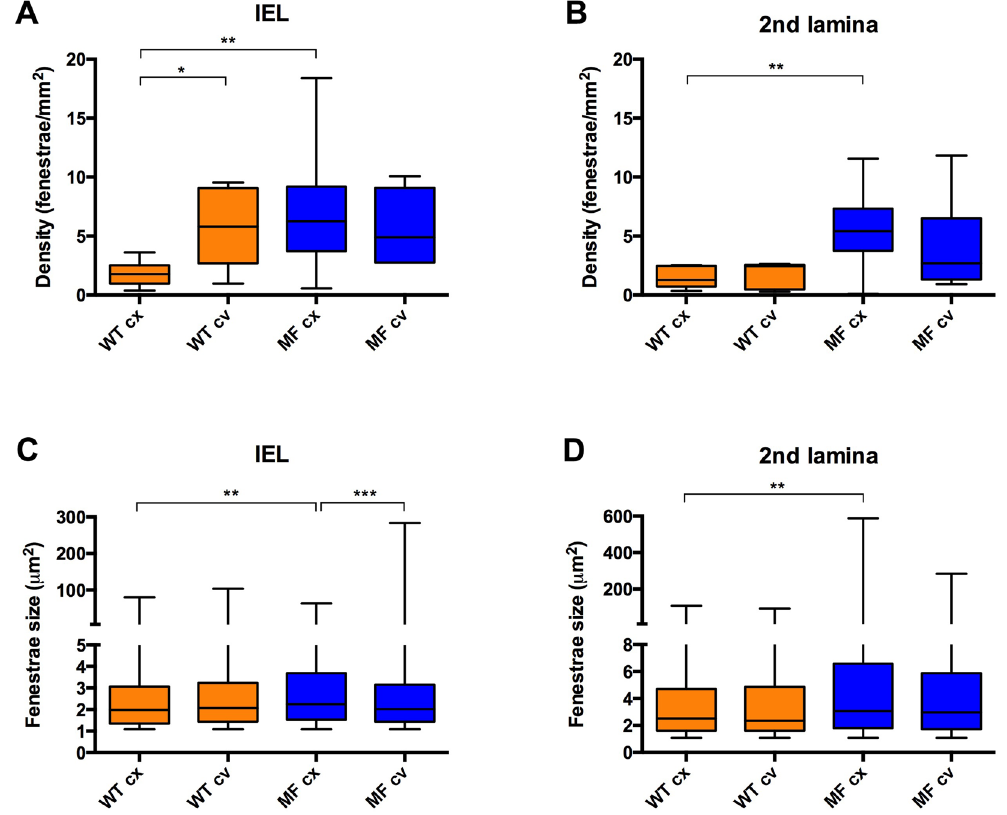
Figure 7. Quantitative analysis of fenestrae in IEL and 2 nd laminae in the circumferential plane of the ascending aorta. The density of fenestrae at the IEL ( A ) and 2 nd lamina ( B ), and their respective individual fenestrae size ( C and D ) measured at different circumferential plane locations (convexity/cx and concavity/cv) of WT (orange) and Marfan (MF, blue) ascending aortae. Statistical significance between groups is indicated by asterisks. Interquartile boxplots with minimum and maximum whiskers. Forty maximal projections were analysed and a total of 6,400 fenestrae were